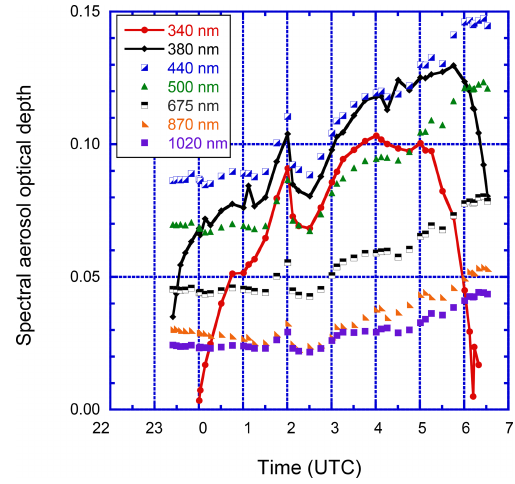
Figure 1. Aerosol optical depth (AOD) data from AERONET Us- suriysk site (43.70 ◦ N, 132.16 ◦ E) on 30 November 2005 show elec- tronic instability. For the Cimel model 4 instruments, the electronic sensitivity of the UV AOD data (340 and 380nm) can be high due to a bad amplifier. The resulting AOD data for the UV channels are out of spectral dependence the entire day with a maximum er- ror for large optical air mass due to large dark current values. The UV channels (identified by line plots) are removed by the quality control while preserving other wavelengths that are not affected by this